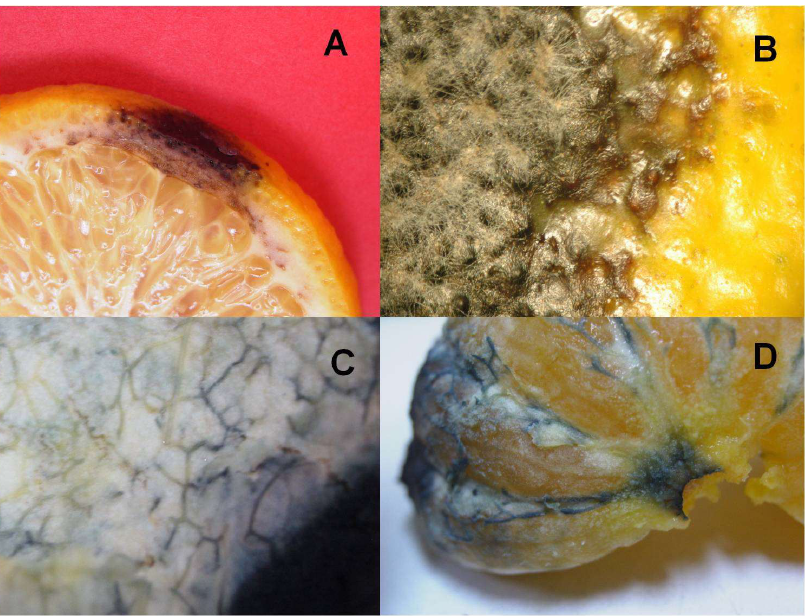
Figure 4. Image of the injury caused by Alt14 on the peel ( A ) and the flavedo ( B ) of ‘Fortune’ mandarin. Location of the laccase activity revealed with ABTS (5 mM) in the albedo ( C ) and in the xylem ( D ) of mandarin ‘Fortune’ infected with Alt14.